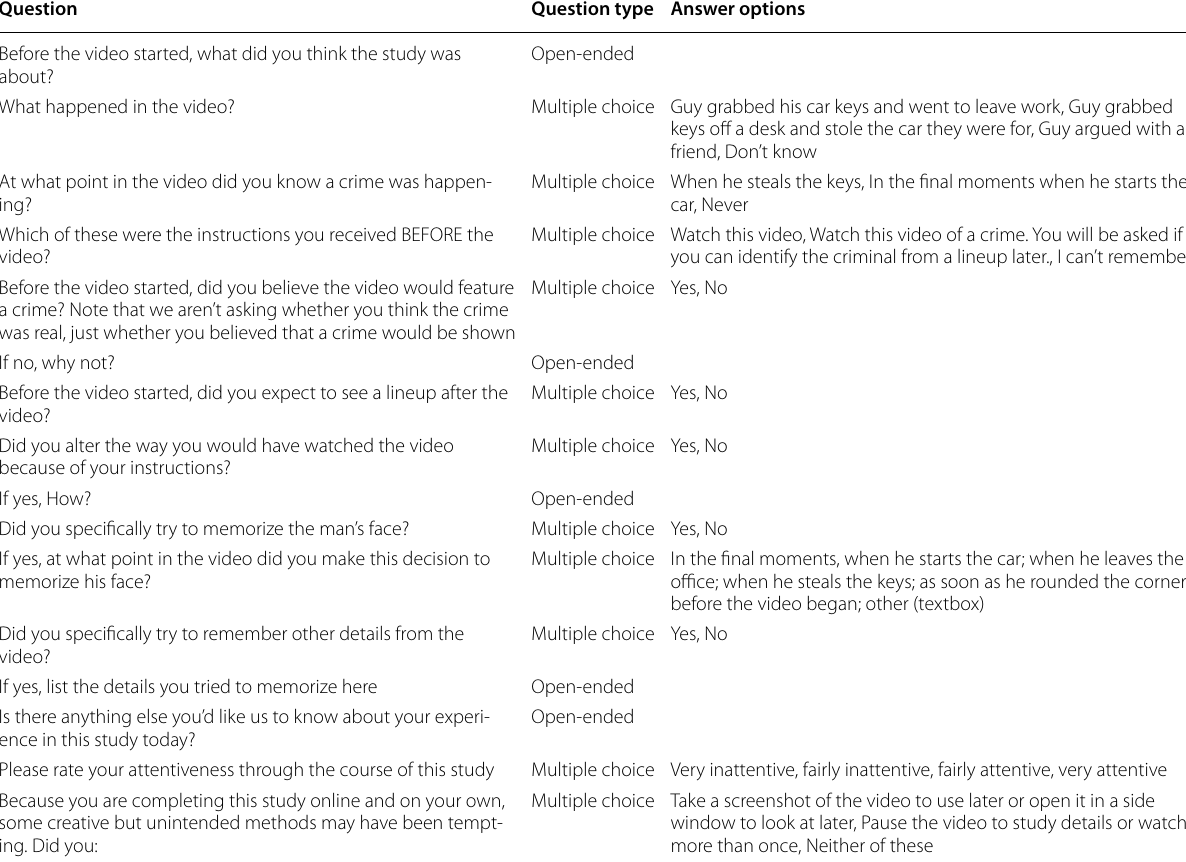
Table 3 Debriefing